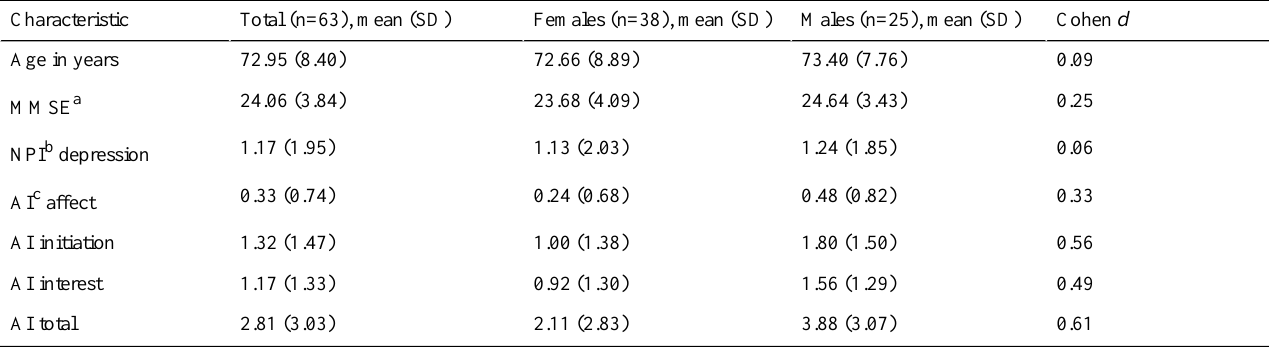
Table 2. Sociodemographic, cognitive, and behavioral variables of study